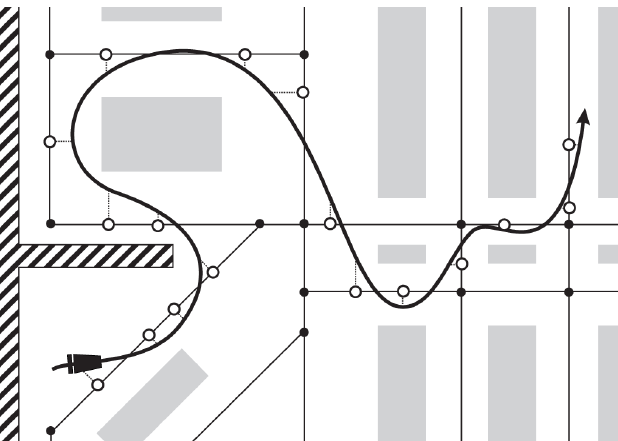
Figure 11. Localization strategy based on aisles graph. Vertices of the aisles graph are marked with • (black dot), and estimated locations are marked with ◦ (white dot). WSN nodes are not visible. All estimated locations reside on the aisles graph edges. The cart is localized after each IR transmission.